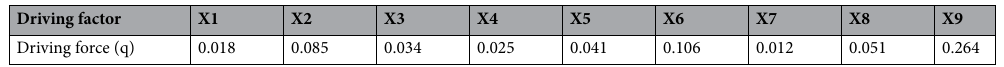
Table 8. q-values of factors influencing spatial variations in HQ.